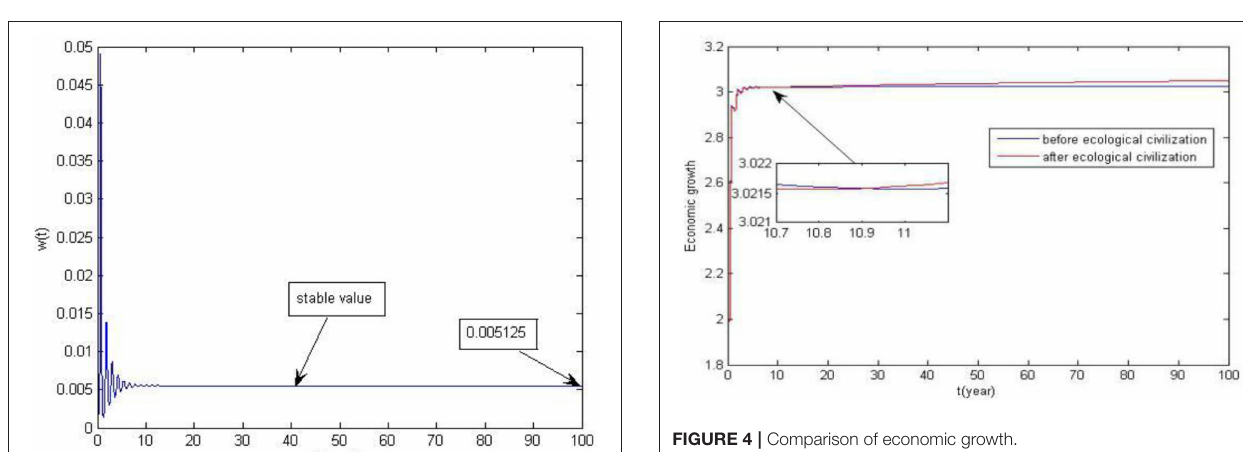
FIGURE 4 | Comparison of economic growth.